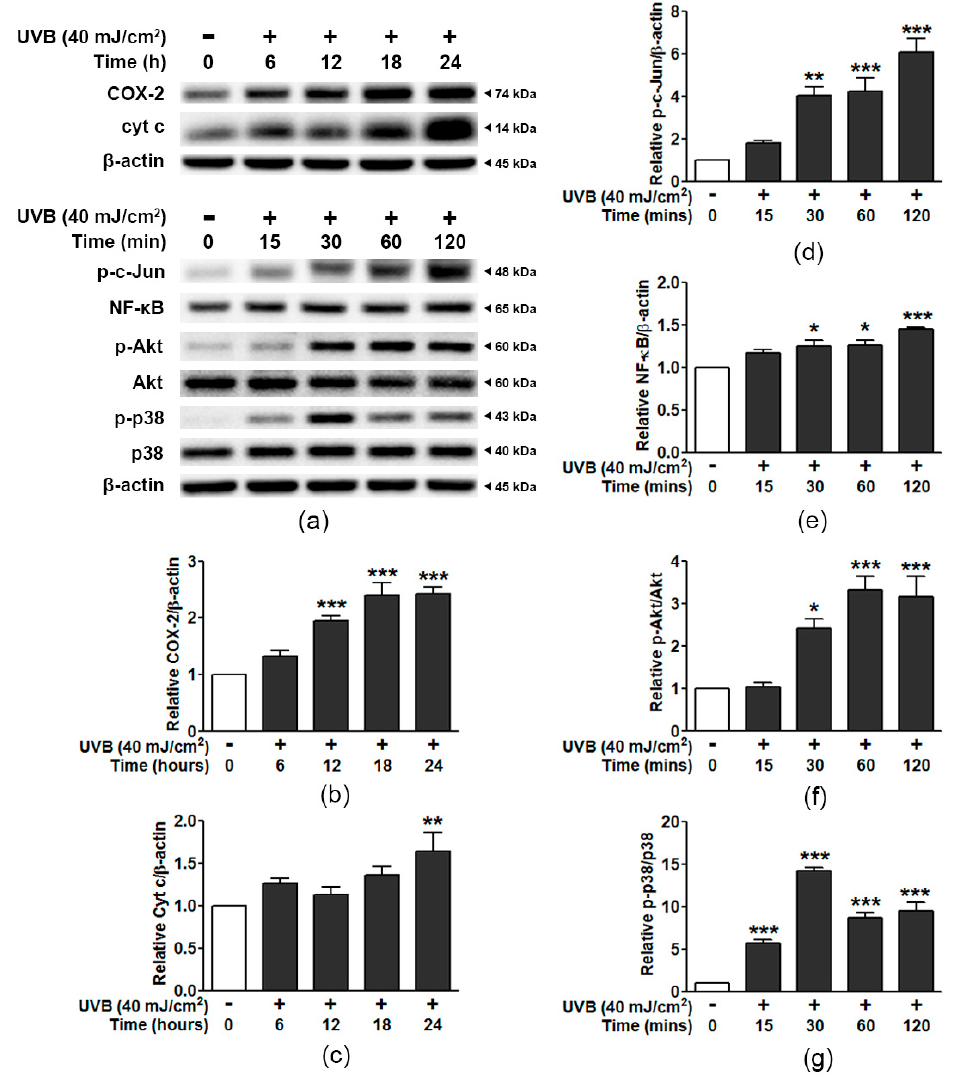
Figure 4. A time-course study of apoptotic and inflammatory signaling changes in HaCaT cells exposed to UVB. ( a ) West- ern blot bands for COX-2 expression and cyt c levels detected at 0, 6, 12, 18, and 24 h and p-c-Jun, NF- κ B, Akt, and p38 detected at 0 to 120 min after UVB irradiation. ( b ) Graphical presentation of the calculated ratios of COX-2/ β -actin and ( c ) cyt c/ β -actin. ( d ) p-c-Jun/ β -actin, ( e ) NF- κ B/ β -actin, ( f ) p-Akt/Akt, and ( g ) p-p38/p38. The data are shown as the mean ± SEM ( n = 3). *, p < 0.05; **, p < 0.01; ***, p < 0.001, when compared to the non-UVB group.